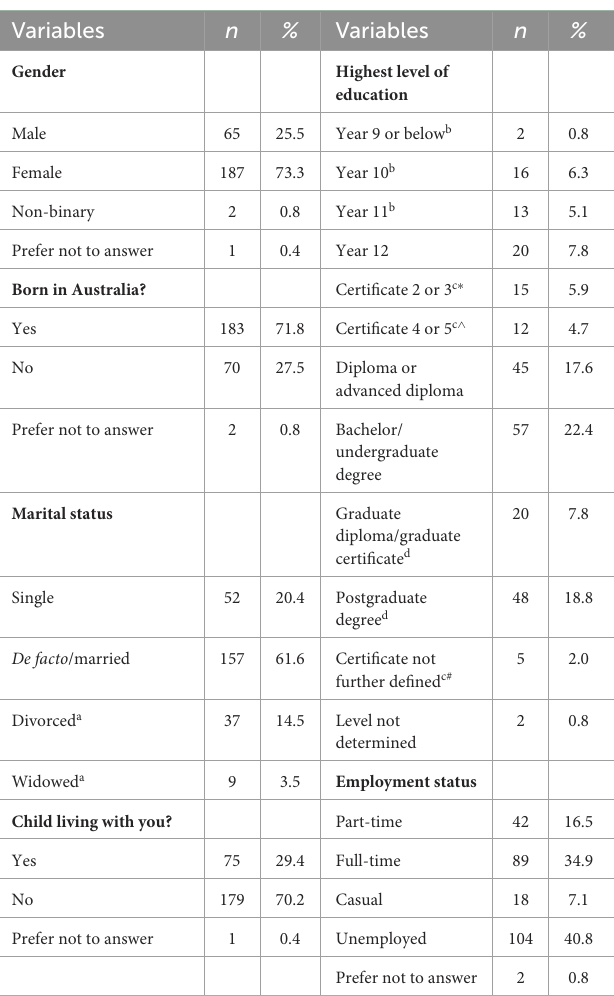
TABLE 1 Participant characteristics for those who provided open-ended